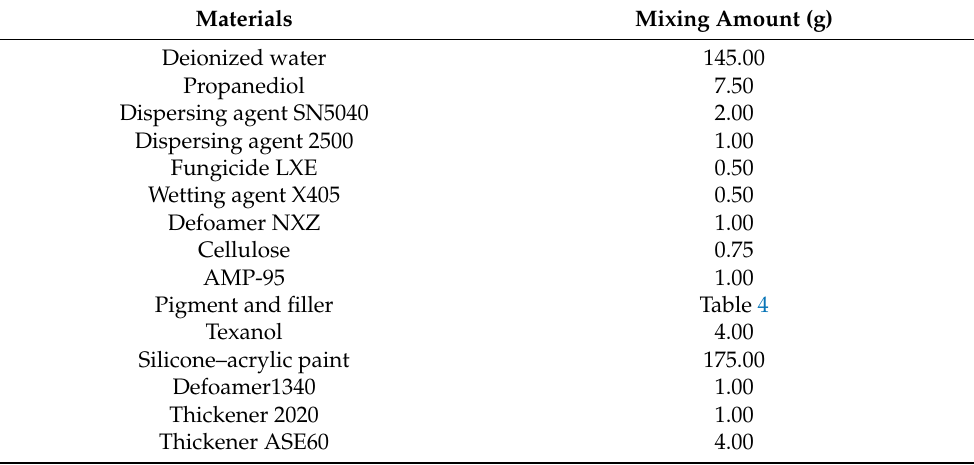
Table 3. Compositions of the paints for Design 2.